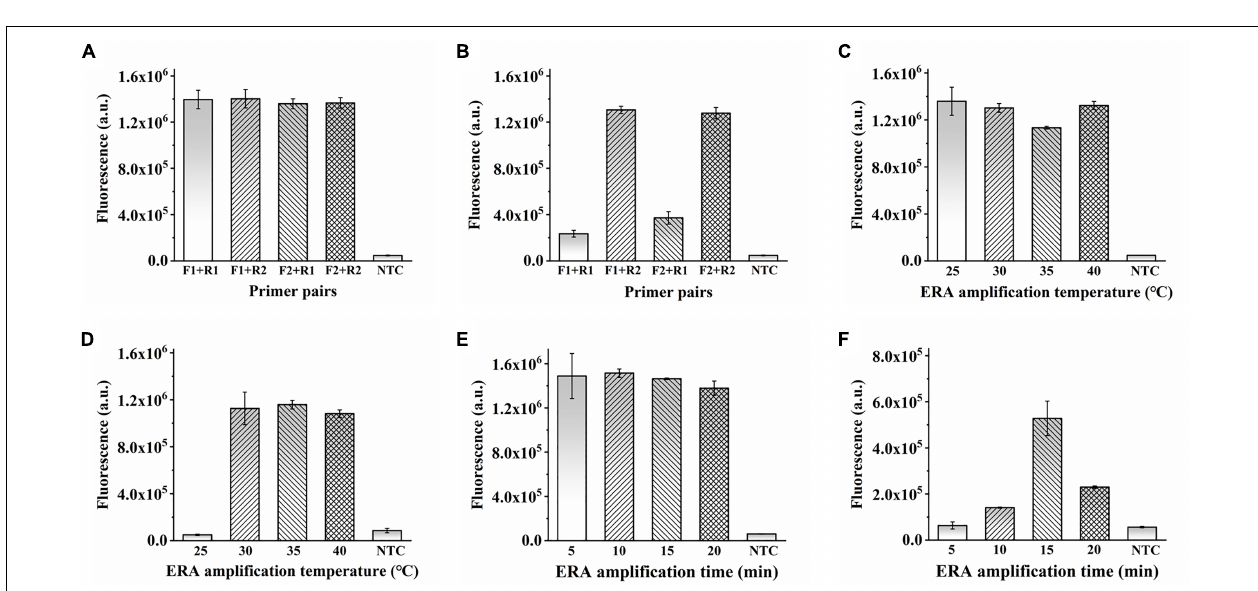
FIGURE 2 | Optimization of CRISPR–Cas12a system in ERA/CRISPR–Cas12a fluorescence system. (A) The importance of ERA amplification for CRISPR system detection. ERA + CRISPR: detection results of the whole reaction system; CRISPR: sample without ERA amplification and directly tested with the CRISPR system. Error bars in panels represent the mean ± SD, where n = 3 replicates. The optimized fluorescence intensity of the system on reaction screening of gRNAs (B) , gRNA concentration (C) , LbCas12a concentration (D) , and F-Q concentration (E,F) , respectively.